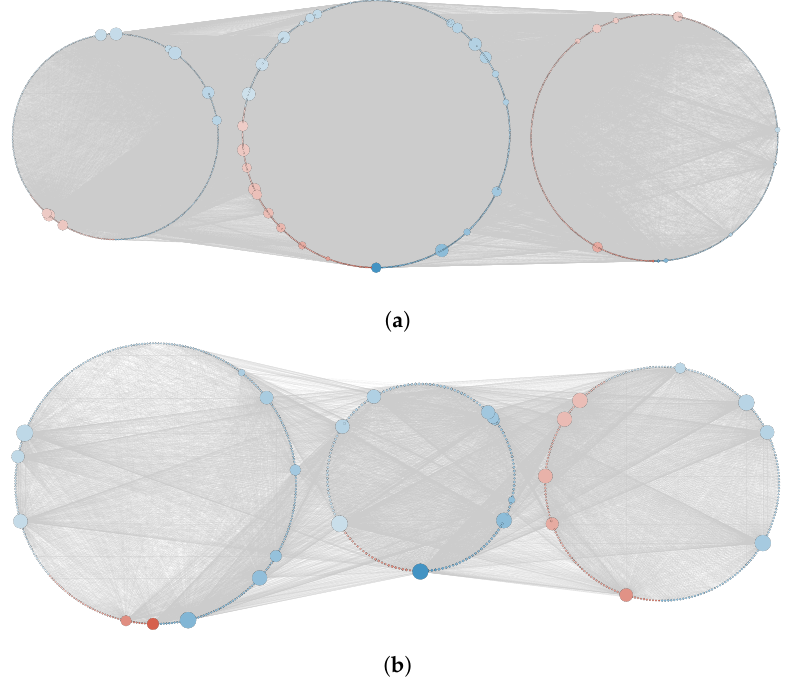
Figure A6. Networks resulting from the organ-wise merging of ( a ) wt and ( b ) ko samples. From left to right, nodes are displayed in circles depending on whether genes are contained exclusively at the wt , in the intersection between the ko and wt networks and in the ko network exclusively. Nodes are sorted and colored according to log2FC, upregulated genes in blue, downregulated genes in red. Node size is represented according to node’s degree.